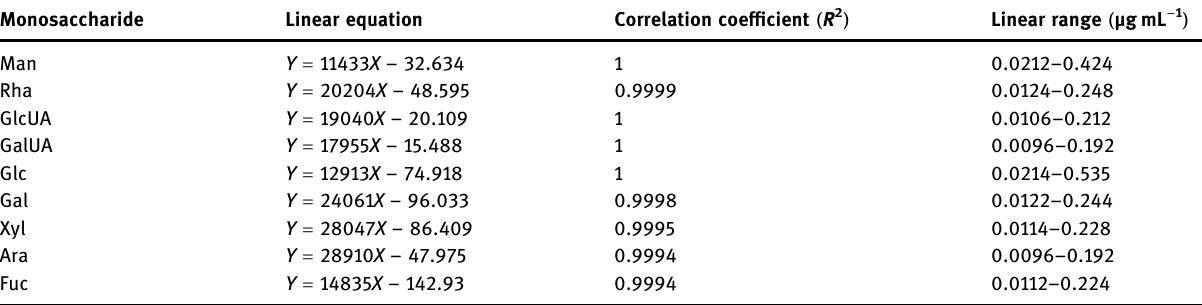
Table 3: Standard curve equation of 9 monosaccharides